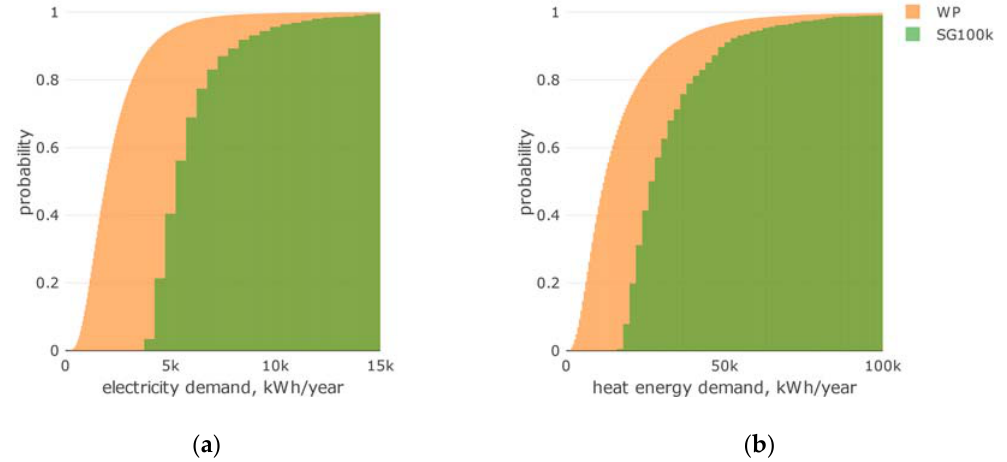
Figure 17. ( a ) Energy demand histogram for heat and electricity for chosen group; ( b ) Produced and overproduced electricity histogram for chosen group. Selected group—Figure 16b for EPI = 1.0 and GPI = 1.0.